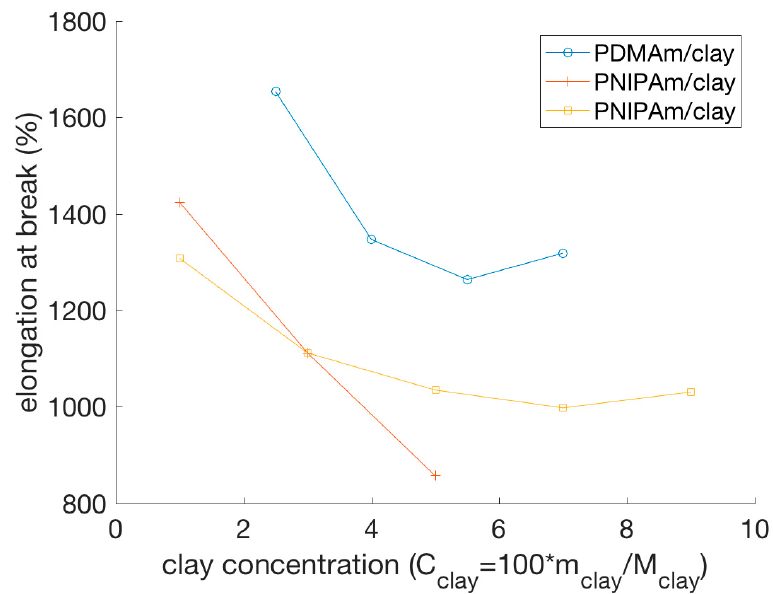
Figure 6. Elongation at break of nanocomposite hydrogels. Data from Haraguchi et al. [17,59,109] of elongations at break for PDMAm and clay hydrogels [109] (blue circles), PNIPAm and clay hydrogels [17] (red crosses), and PNIPAm and clay hydrogels [59] (yellow squares) replotted as a function of clay concentration C clay .